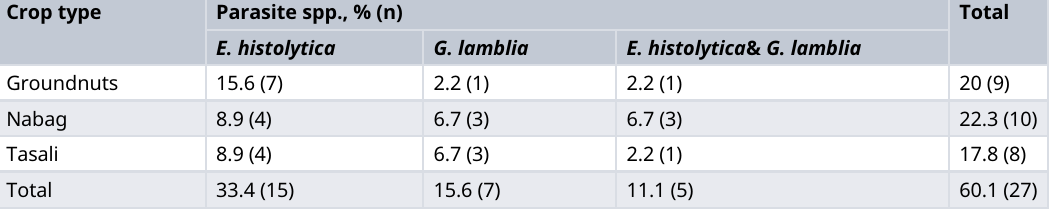
Table 3. Correlation between crop type and detected parasite